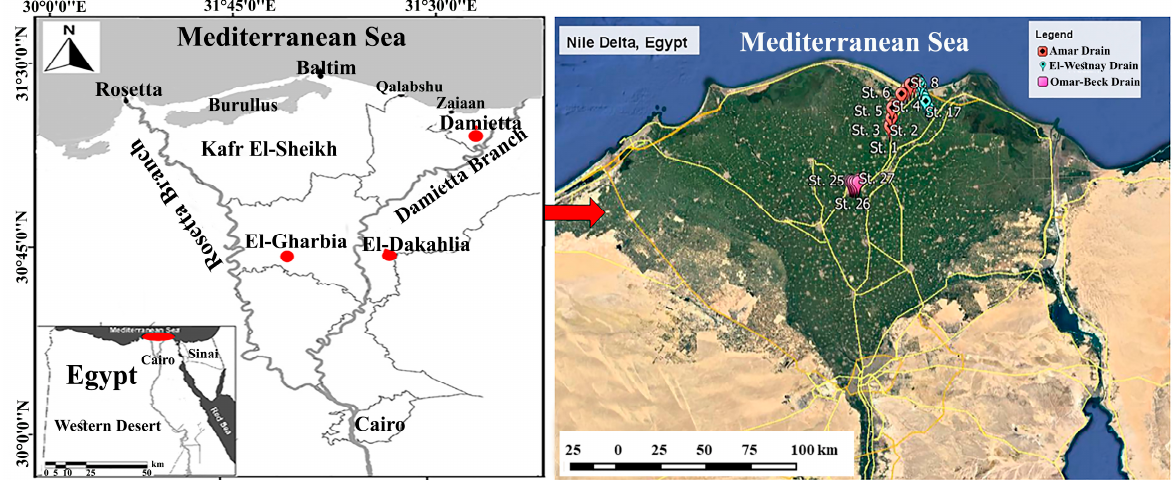
Figure 1. Map of the Nile Delta of Egypt showing the sampling sites (St. 1–St. 27) in the three drains (Amar, El-Westany, and Omar-Beck). Map source: Google Earth Pro v. 7.3.3.7886, accessed on 25 August 2020.